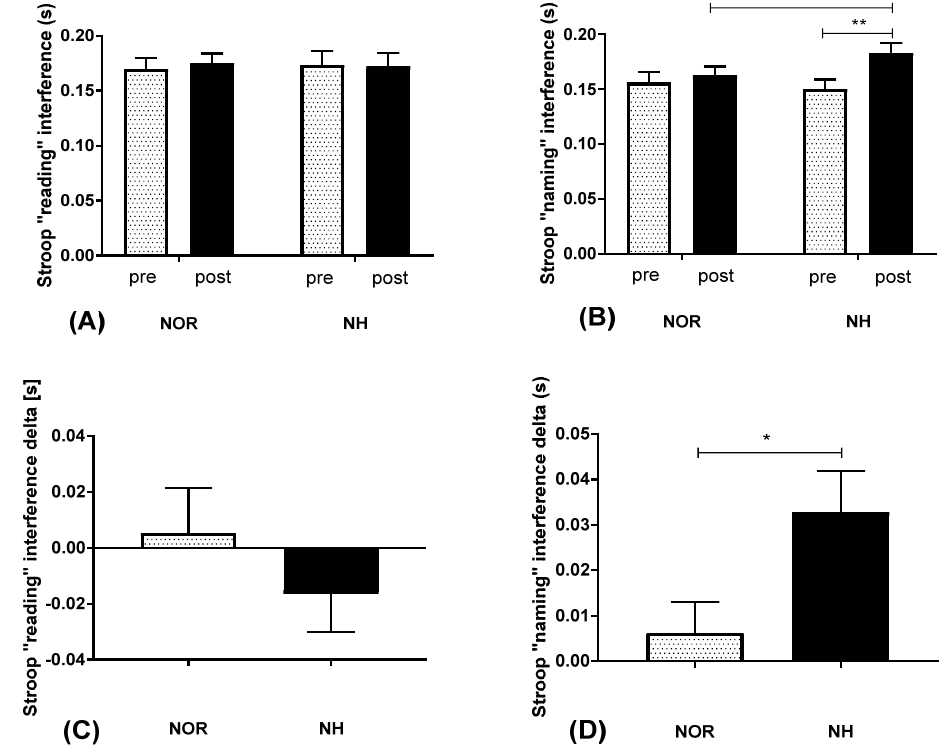
Figure 2. Effect of normoxia and acute normobaric hypoxia at FIO 2 = 13% on post-exposure interfer- ence values in reading ( A ) and in naming ( B ). Subsections ( C , D ) represent their deltas. Values are means. Error bars indicate SEM (standard error of the mean). * p < 0.05; ** p < 0.01. NOR—normoxia; NH—normobaric